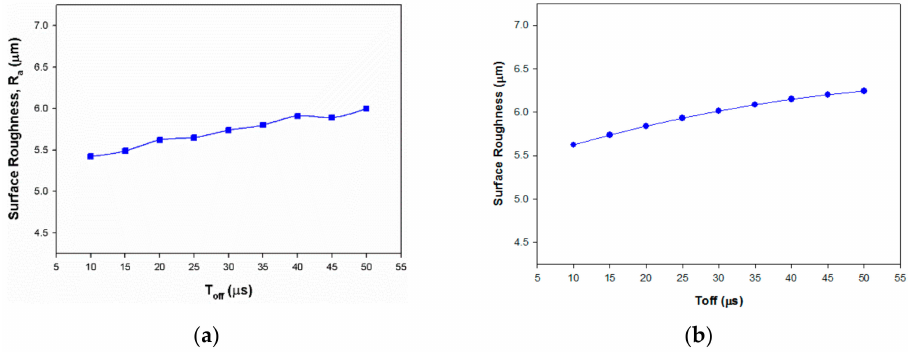
Figure 11. Main effect plots for SR with T off using ( a ) DOE model; ( b ) machine learning